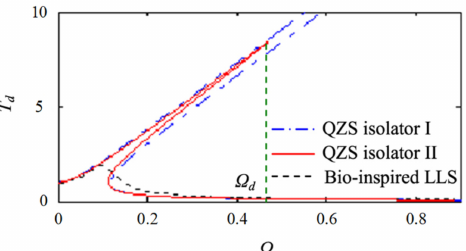
Figure 20. Comparison of isolation performance between bio-inspired isolator and typical QZS isolators by Wu et al.